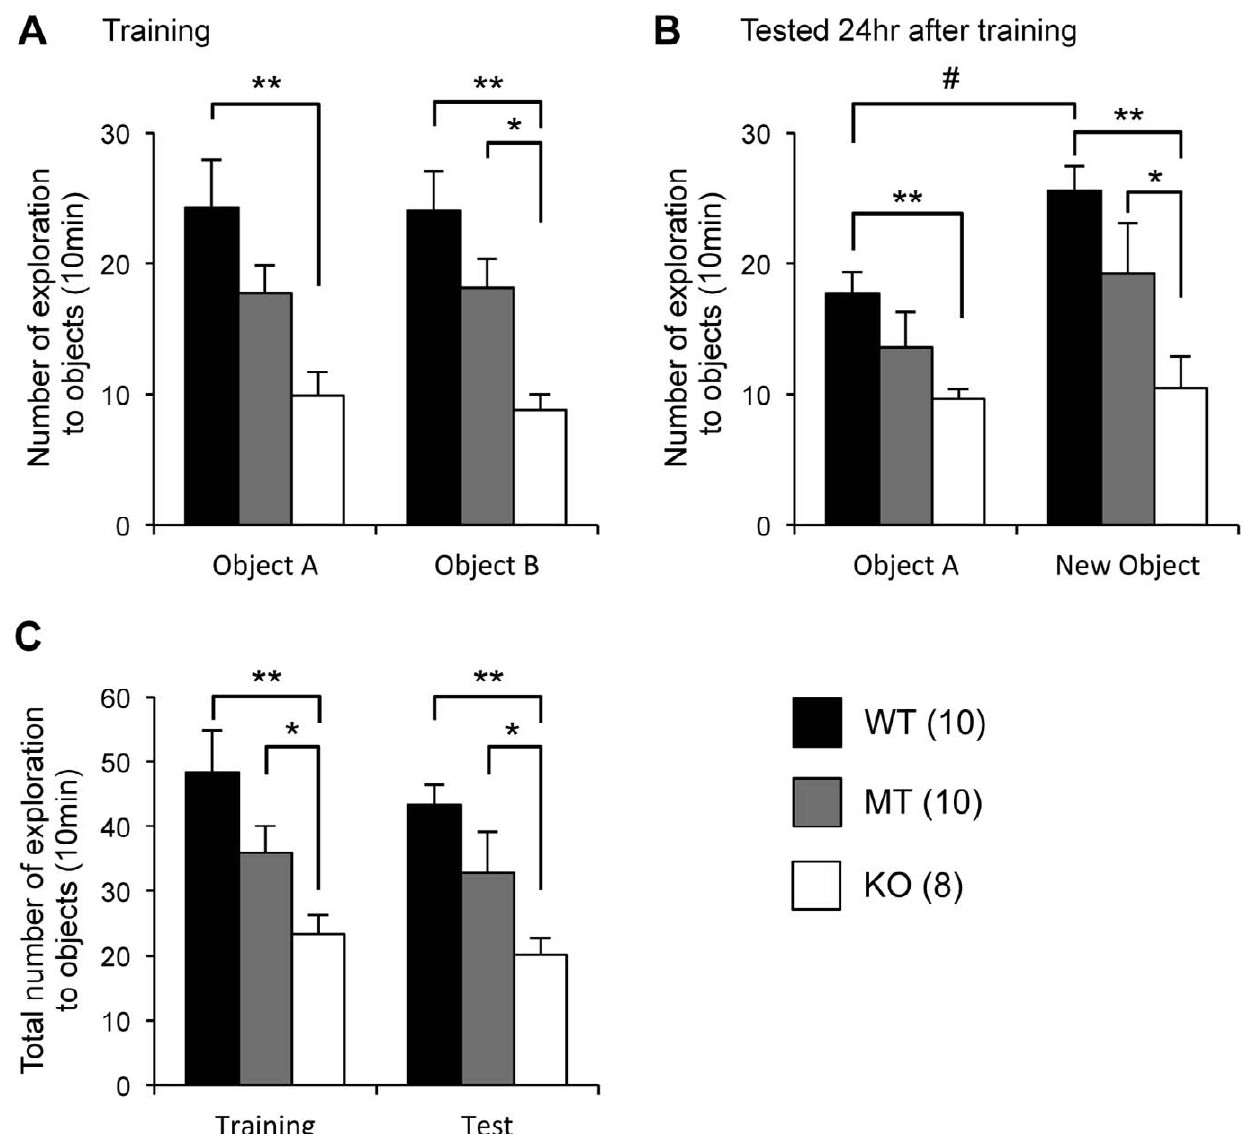
Figure 6. Novel object recognition test. (A) Number of explorations of the 2 objects on the training day. Compared to WT mice, Usp46 KO mice showed significantly lower numbers of explorations for each object. The number of explorations for object B made by KO mice was also significantly lower than that by MT mice. (B) A familiar object was substituted by a novel object at 24 hours after the training. The number of explorations for the novel object was significantly increased for the WT mice, but not for Usp46 MT and KO mice. (C) Total number of explorations for the objects on the training day and 24 hours after the training. The number of explorations made by KO mice was significantly lower than those by WT or MT mice. The number of mice used is shown within parentheses. One-way ANOVA with Fisher’s PLSD test; * P , 0.05, ** P , 0.01. Student’s t test; # P ,